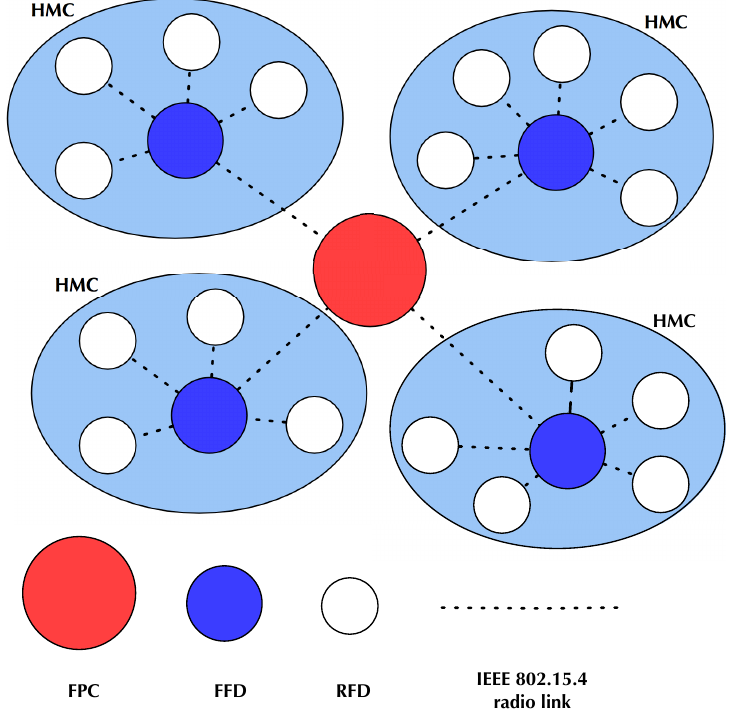
Figure 1. Network